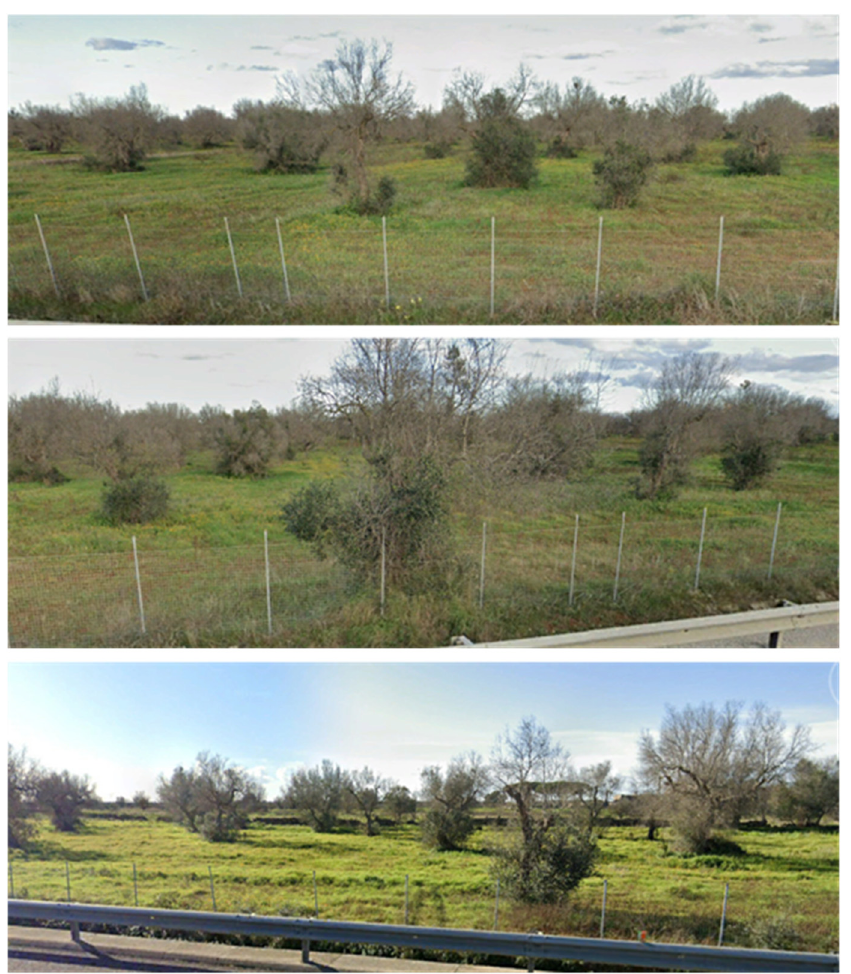
Figure 11. Pictures of the olive groves affected by Xylella fastidiosa in the province of Lecce until 2021. Table 5. Land Surface Temperature differences between olive groves and farmland from 2014 to 2020. Years LST Difference between Farmland and Olive Groves ( ◦